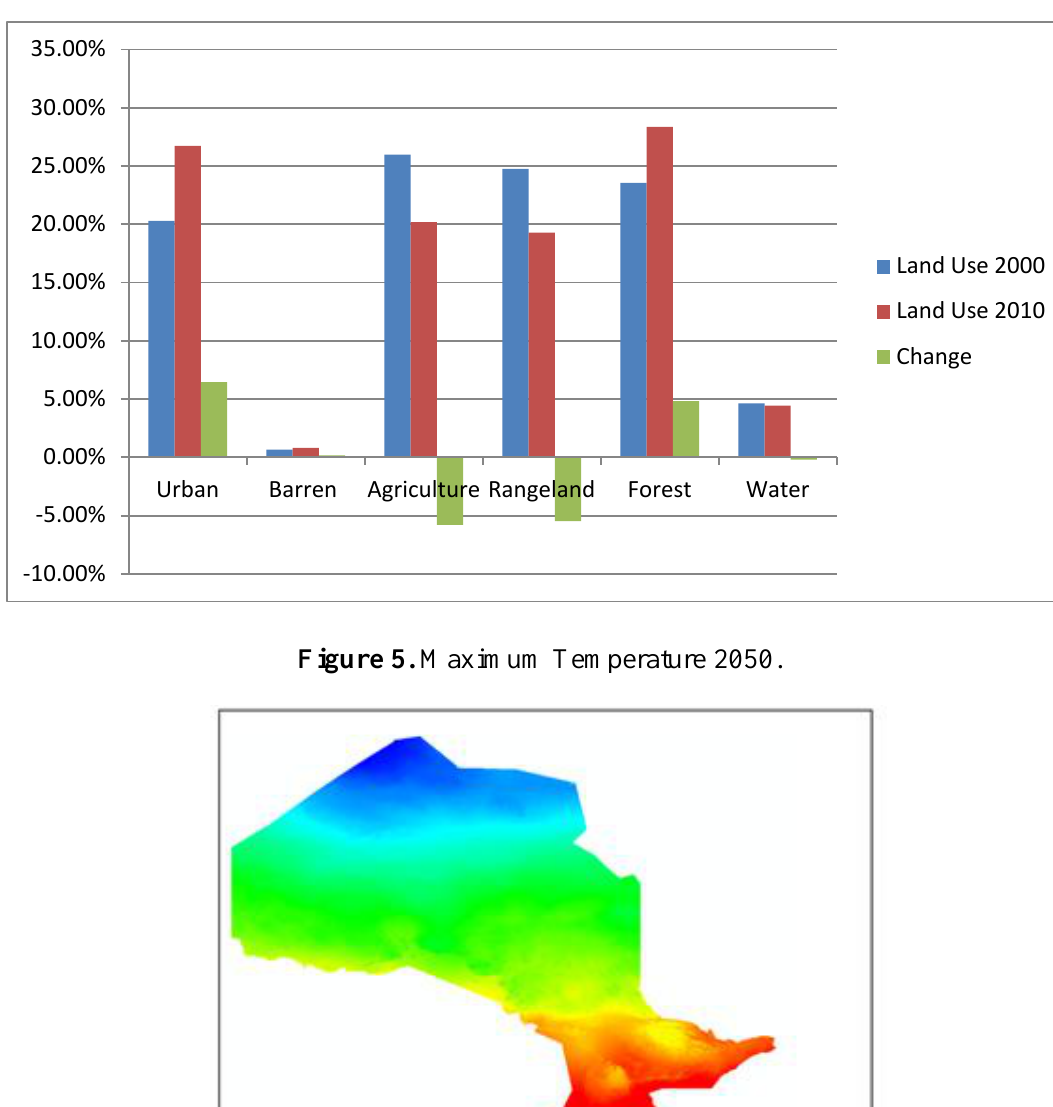
Figure 4. Land use dynamics and change between 2000 and 2010.